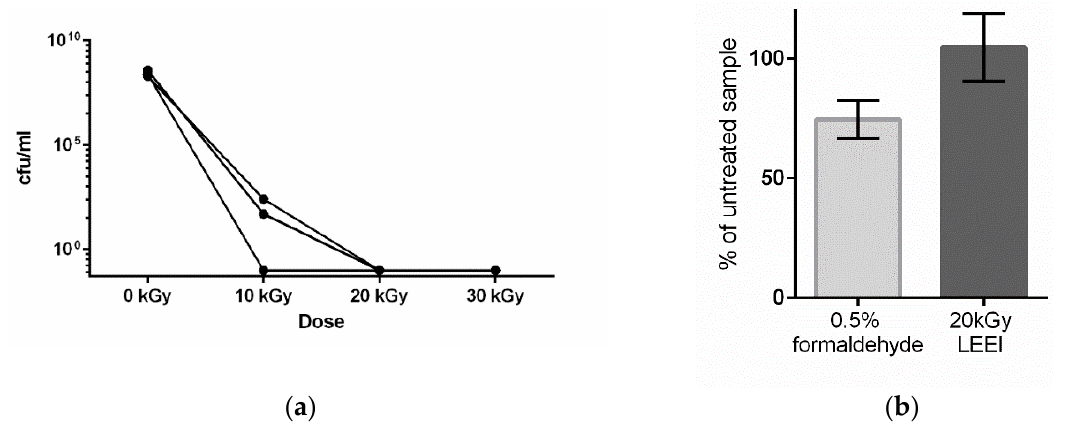
Figure 1. E ff ect of low-energy electron irradiation (LEEI) on R. pneumotropicus . ( a ) R. pneumotropicus was irradiated with increasing doses and the resulting colony forming units in the samples were determined. Each curve represents one irradiation experiment with one batch of bacteria. ( b ) Analysis of the conservation of antigenic structures. Equal amounts of LEEI- or formaldehyde-inactivated bacteria were coated on ELISA plates and probed with polyclonal serum from R. pneumotropicus infected mice. Measurements with untreated bacteria were used as a reference (set to 100%, error bars represent the standard deviation). The di ff erences are not statistically significant ( t -test, unpaired, two-sided). In order to compare di ff erent inactivation methods, the bacteria were inactivated in two di ff